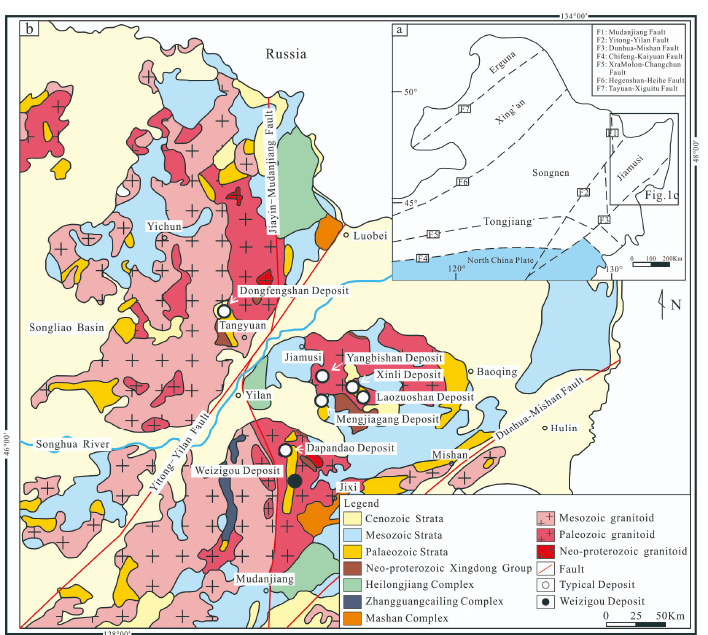
Figure 1. ( a ) Tectonic location map of Northeast China (modified after Wu et al. [35]); ( b ) regional geological map of Jiamusi Area (modified after Wang et al. [29]). Among these, the Mashan complex is considered to be the metamorphic basement of the Jiamusi massif. It is composed of a set of khondalite series containing graphite and phosphorus that is aluminum rich and intercalated with marble, calcium silicate rocks and quartz schist. This series has undergone amphibolite facies to granulite facies metamor- phism and is mainly distributed in Jixi, Luobei and other areas [34,36–38]. The Hei- longjiang complex is mainly distributed in the north and south of the region and shows an irregular distribution. Generally, the complex is a set of argillaceous schist, metamor- phic basic rock, ultrabasic rock, metamorphic siliceous rock and marble formed by the metamorphism of blue schist–green schist facies affected by intense deformation in the later period. This complex has been considered as ophiolite structural melanges formed in during the collage of the Jiamusi block and the Songliao block. [32,39–41]. The sedimen- tary caprocks of the Paleo-Mesozoic are mainly distributed across the eastern margin of the region, including two structural layers from the bottom to the top. The bottom part is the Lower Devonian-Lower Carboniferous marine and marine-terrestrial clastic rocks, which are unconformized in the Early Paleozoic granite, while the upper part is developed